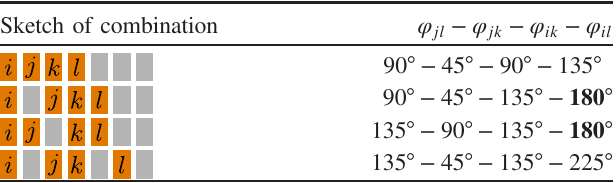
TABLE III. Indices i , j , k , l and phases appearing model phase advances for the closest combinations. The actual model phase advances depend on the respective model settings and differ slightly from the exact values above. Sketch of combination